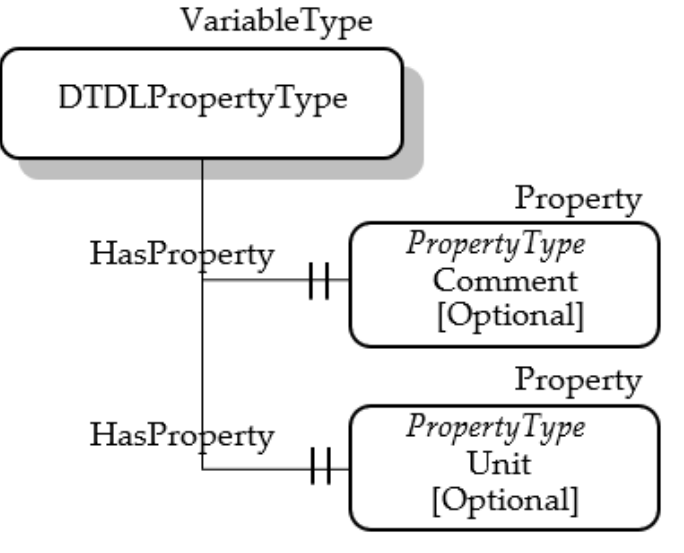
Figure 6. OPC UA DTDL PropertyType.